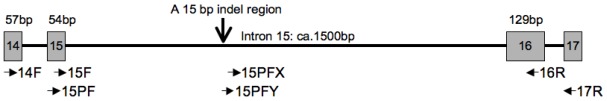
The positions of primers for PgiC gene from exon 14 to exon 17. Exons and introns are drawn to scale. Small arrows show positions and directions of the primers and the vertical arrow indicates the largest indel region.